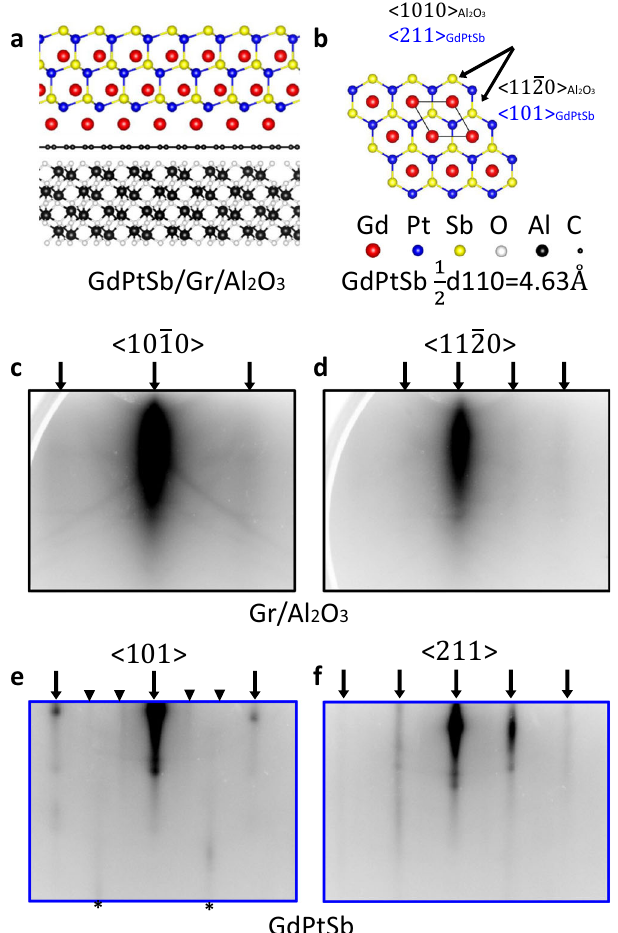
Fig. 2 Epitaxy of GdPtSb on graphene-terminated Al 2 O 3 (0001). a Schematic crystal structure of (111)-oriented cubic GdPtSb on graphene/ Al 2 O 3 (0001). The lattice parameter for Al 2 O 3 is a = 4.785 Å and that of d ¼ 4 : 53 Å , corresponding to a mismatch of 2.7%. b In-plane GdPtSb is 1 110 2 crystal structure of GdPtSb (111). c , d Re fl ection high-energy electron diffraction (RHEED) patterns of graphene on Al 2 O 3 after a 700 °C annealing. Black arrows mark the underlying Al 2 O 3 re fl ections. e , f RHEED patterns for the GdPtSb fi lm. Black arrows mark the bulk re fl ections. Triangles mark superstructure re fl ections from a 3 × surface reconstruction. Additional re fl ections (black asterisks) are observed that correspond to a second domain rotated by